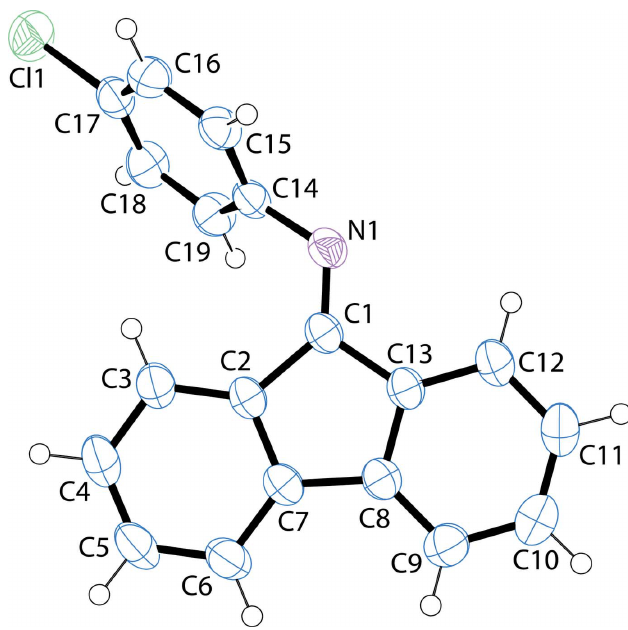
Figure 1 The molecular structure of the title compound showing 50% probability displacement